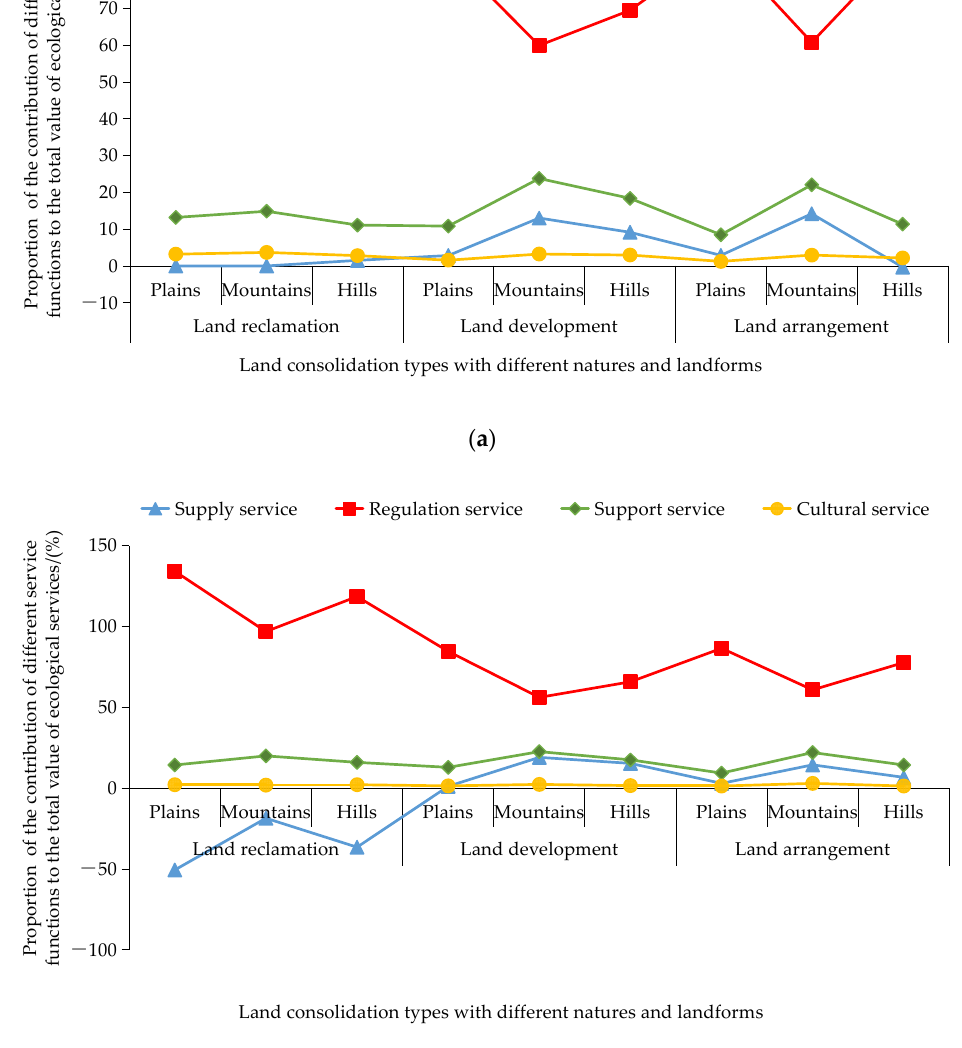
Figure 7. Proportion of the contribution of different service functions to the total value of ecological services before and after consolidation in typical land consolidation project areas in Hubei province: ( a ) Before consolidation; ( b ) After consolidation.